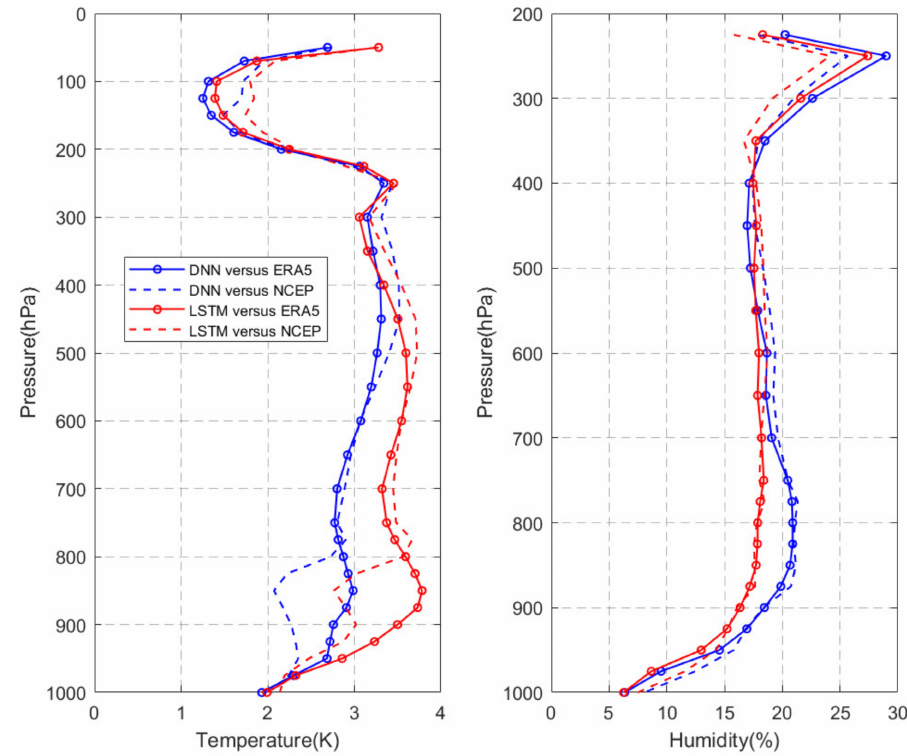
Figure A6. The retrieval RMSEs of the DNN model and the LSTM model with respect to ERA5 and NCEP reanalysis data over mixed ice–water in September